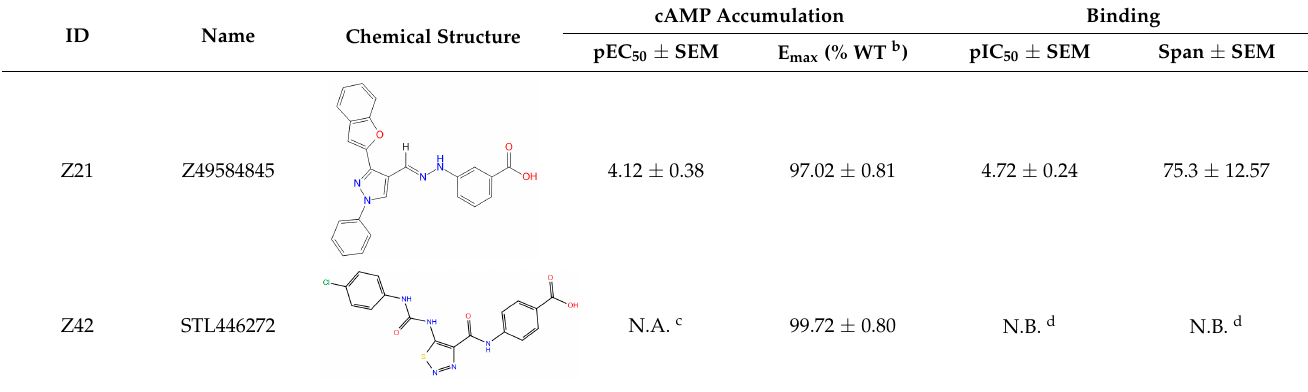
Figure 4. Experimental validation of selected compounds identified using SBVS. ( A ) Dose-dependent inhibition curves of Z21 and Z42 on cAMP activity induced by constant concentration of GLP-1 (0.08 nM for Z21, 0.05 nM for Z42) in GLP-1R expressing CHO-K1 cells. ( B ) Binding of Z21 or Z42 to GLP-1R or its mutants in competition with radiolabeled GLP-1. Data are presented as means ± S.E.M. of three independent experiments. Table 1. Experimentally validated new NAMs based on SBVS approach a .